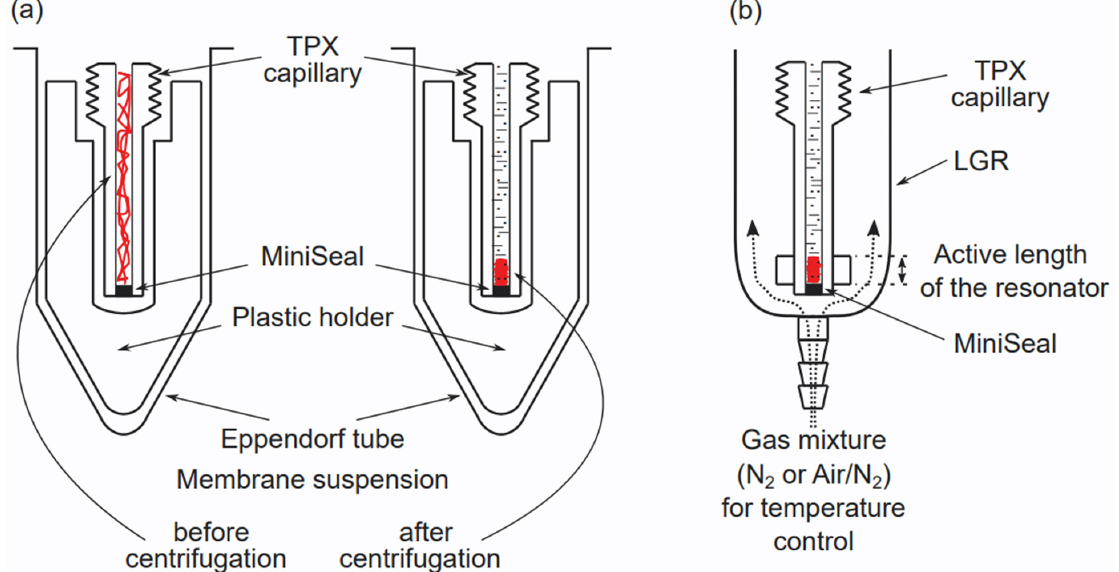
Figure 3. ( a ) This schematic drawing shows the basic strategy for handling samples of multilamellar liposomes made from a small amount of material. After the first concentrating (pelleting) of diluted samples to the volume of the TPX capillary, the suspension of multilamellar liposomes is further pelleted on the bottom of the TPX capillary to the lens of the active region of the loop-gap resonator (LGR). As shown in ( b ), the TPX capillary is then transferred from the special holder in the Eppendorf tube to the loop-gap resonator and equilibrated with the appropriate mixture of nitrogen and air; then, EPR measurements are performed with the possible maximal signal coming from that limited